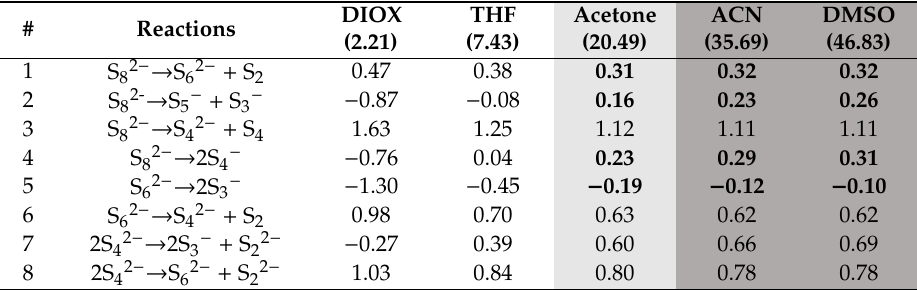
Table 2. The reaction free energies ( ∆ G, eV) of lithium polysulfides in different solvents. The dielectric constants ( ε ) of different solvents are presented in parentheses. The solvents that tend to facilitate the